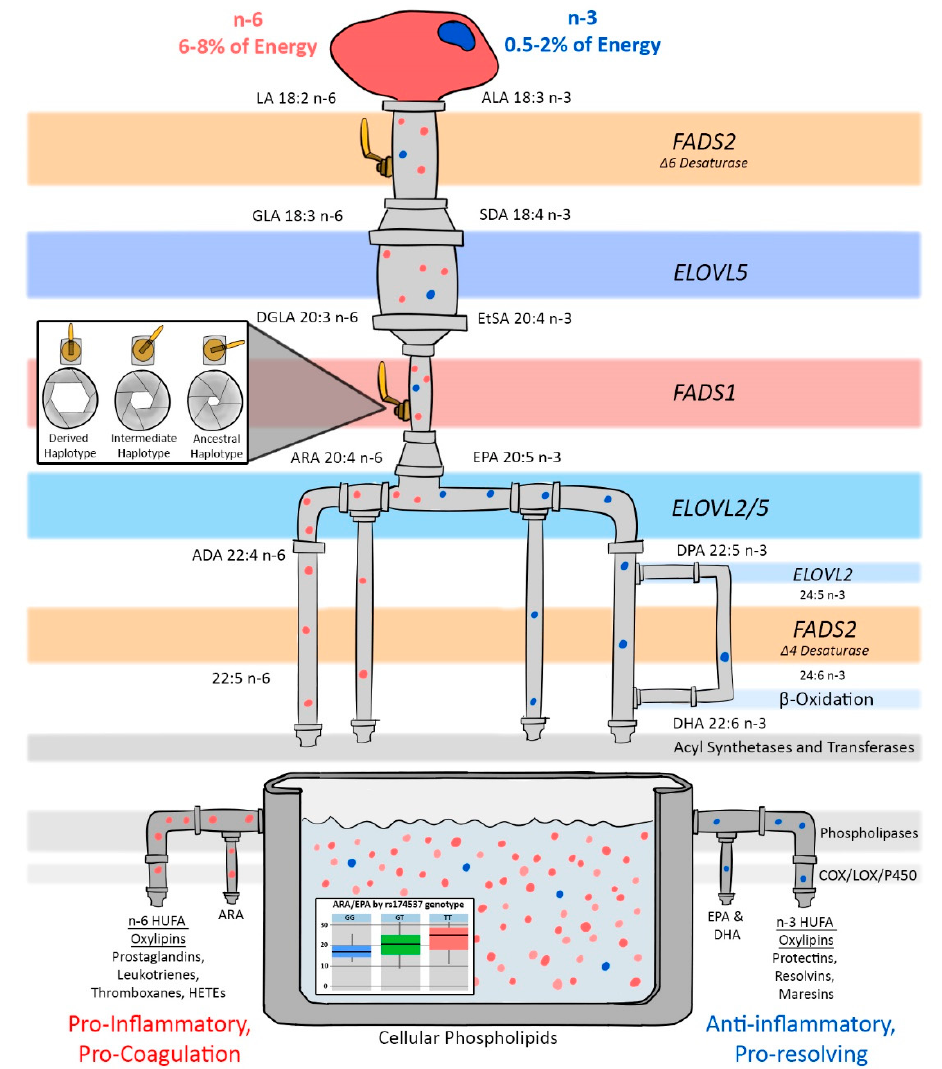
Figure 1. Illustration of the LC-PUFA biosynthesis pathway showing how FADS haplotypes utilize dietary n -3 and n -6 PUFAs for the biosynthesis of LC-PUFAs and their bioactive metabolites such as prostaglandins, oxylipins, leukotrienes, thromboxanes, HETEs, protectins and resolvins. Recent studies suggest that genetic variation in FADS1 plays a critical role in impacting the efficiency of the FADS1 ( ∆ 5 desaturase) biosynthetic step and this represents the rate-limiting step in the formation of LC-PUFA-containing structural lipids and signaling molecules [57,59]. In this illustration, genetic control of the FADS1 and FADS2 steps are represented by the valve handle in the FADS steps. When the handle is wide open, as is the case for people with two copies of the derived haplotype, individuals have the ability to more efficiently synthesize LC-PUFAs from dietary 18C-PUFA precursors (n -3 and n -6). When the handle is partially closed, as is the case for people with one copy, individuals have intermediate efficiency. The valve handle is almost closed for people with an ancestral haplotype, and thus the LC-PUFA biosynthesis efficiency is lower. Additionally, the efficiency through the pathway has a direct role on the ratio of n -3 and n -6 LC-PUFAs that accumulate in phospholipid pools (as indicated in the container in this figure). FADS = fatty acid desaturase; ELOVL = fatty acid elongase; LA = linoleic acid; ALA= alpha linolenic acid; DGA = gamma linolenic acid; DGLA= dihomo-gamma-linoleic acid: EsTA= eicosotraenoic acid; EPA=Eicosopentanoic acid; DHA = Docosahexanoic acid; ARA= araquidonic acid; DPA = Docosopentanoic acid; COX = Cyclooxygenase; LOX= lipoxygenase and HUFA-highly unsaturated fatty